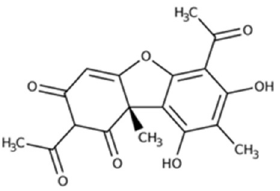
Figure 1. Chemical structure of usnic acid.